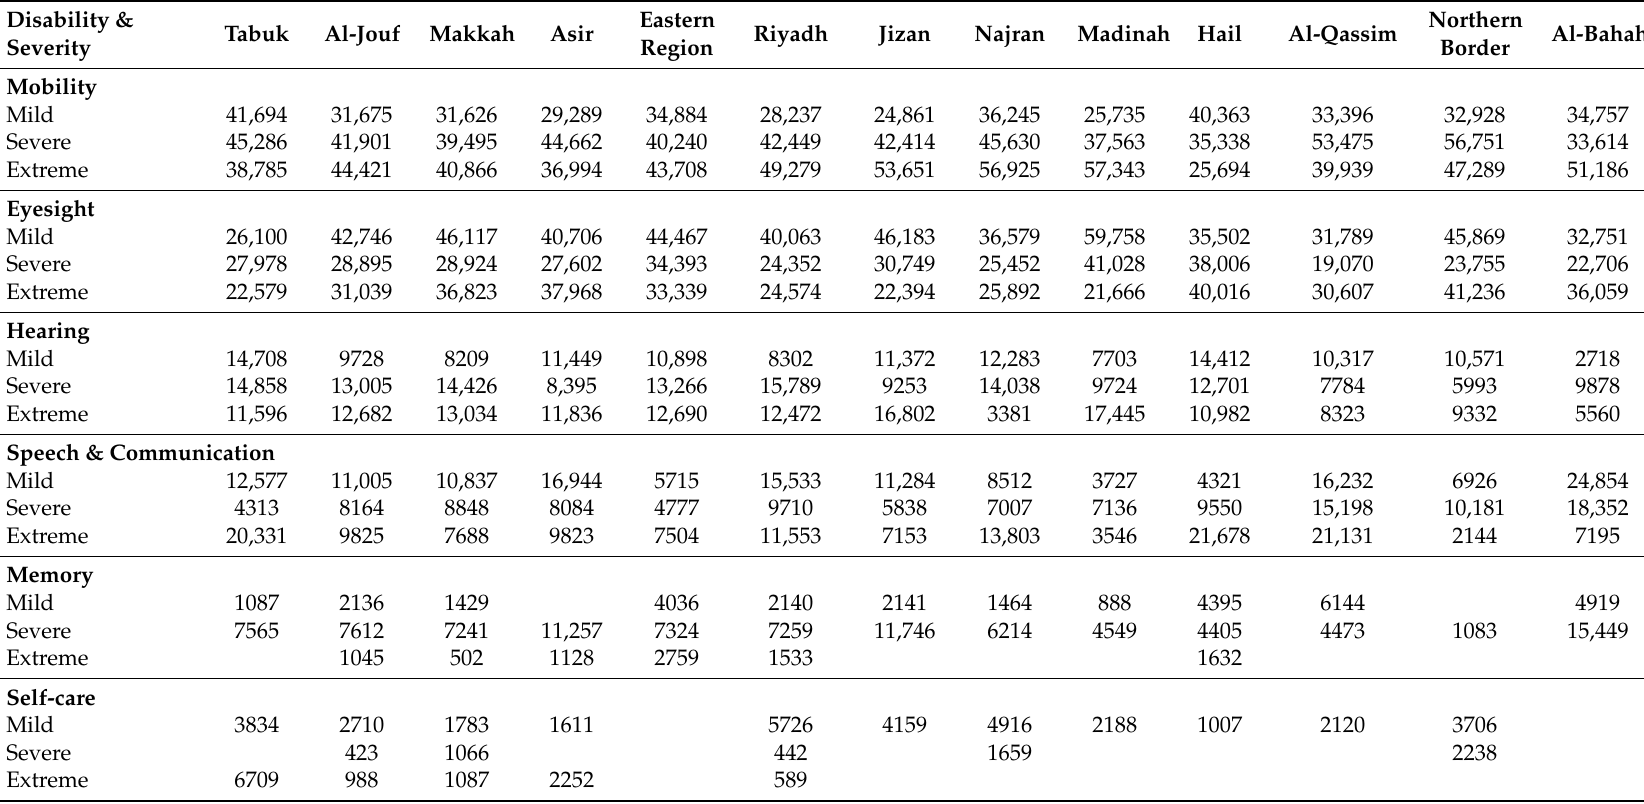
Table 3. Disability prevalence rates per 100,000 populations in 2016 in all 13 administrative regions according to type of disability and